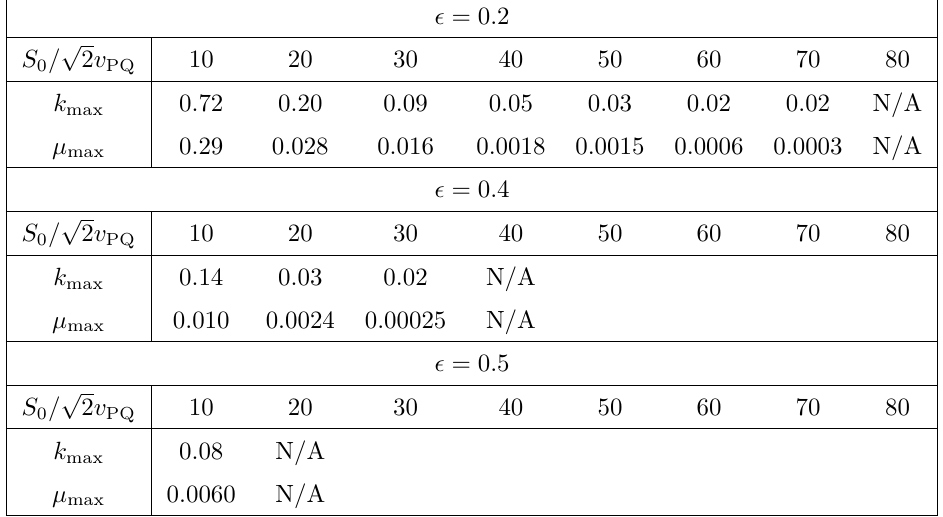
Table 4 . The wave number k max having maximal growth rate µ max , for the theory with the superpotential W = X ( P ¯ P − v 2 ) PQ